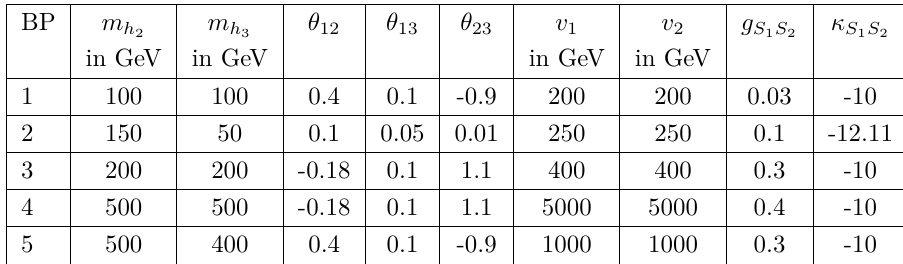
Table 1. The chosen five benchmarks points (BPs, BP 1–5) to explore the GW production from both the domain walls and strong first-order phase transition in two complex scalars extended